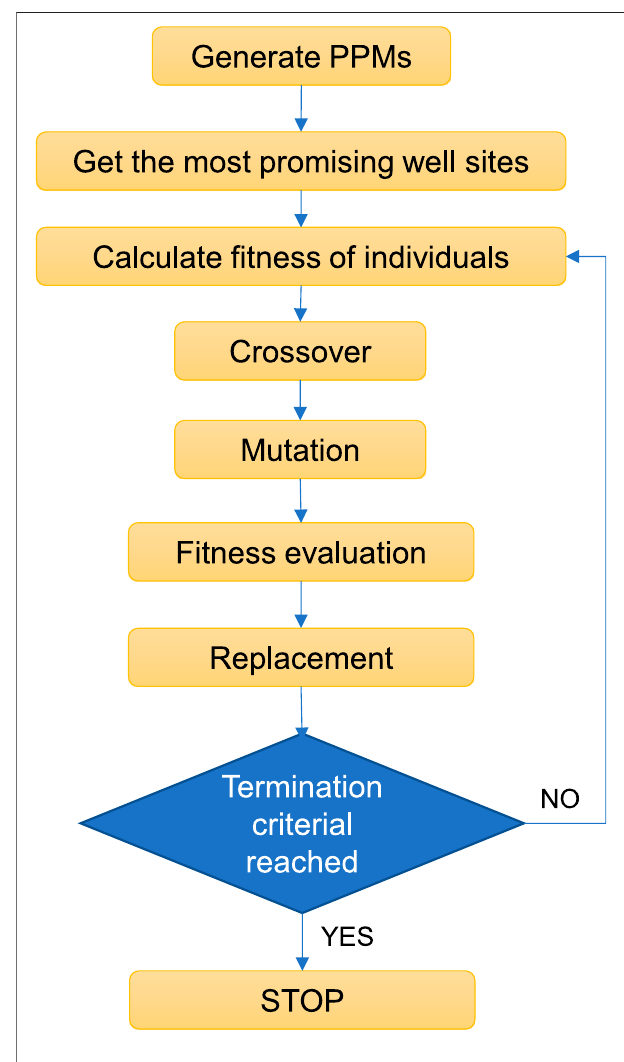
FIGURE 3 | Optimizing well placement procedure proposed by GA and